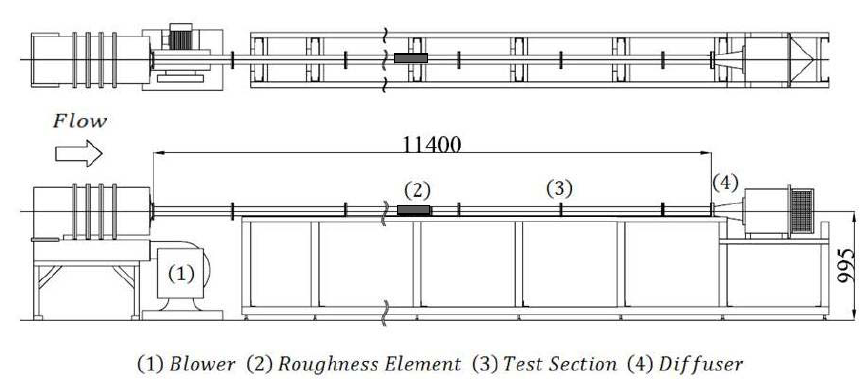
Fig. 1 Experimental setup for pipe